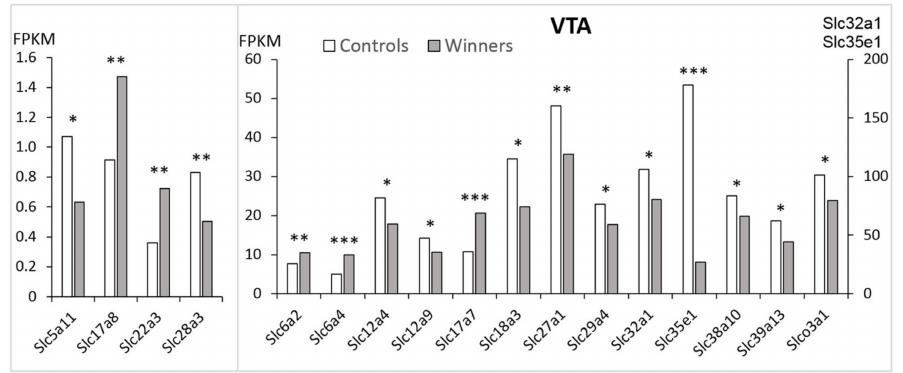
Figure 1. The Slc DEGs in the VTA of mice. White columns: controls; grey columns: winners.